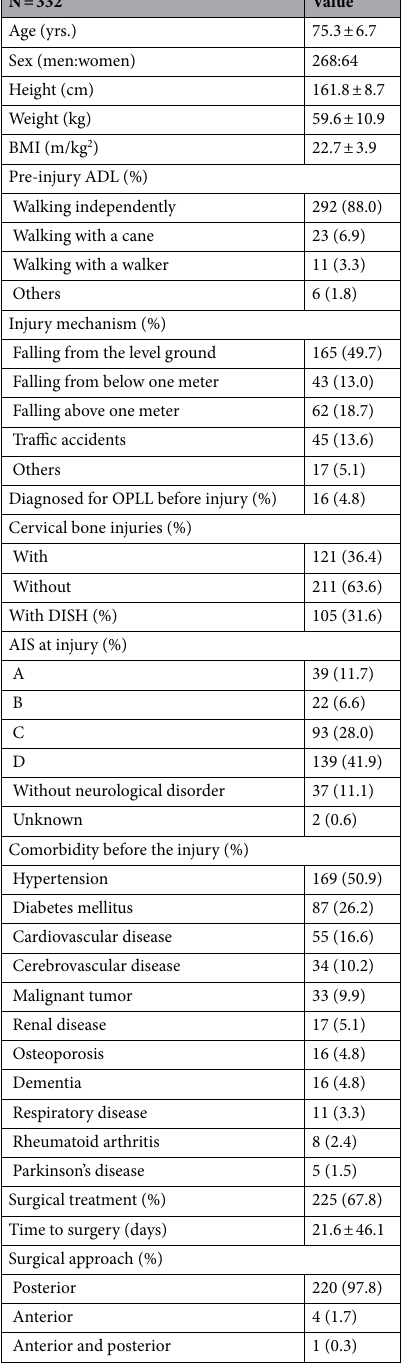
Table 1. Demographic characteristics of older patients with CSCI with OPLL. CSCI, cervical spine cord injury; OPLL, ossification of the posterior longitudinal ligament; AIS, American Spine Injury Association impairment scale; DISH, diffuse idiopathic skeletal hyperostosis; and ADL, activities of daily